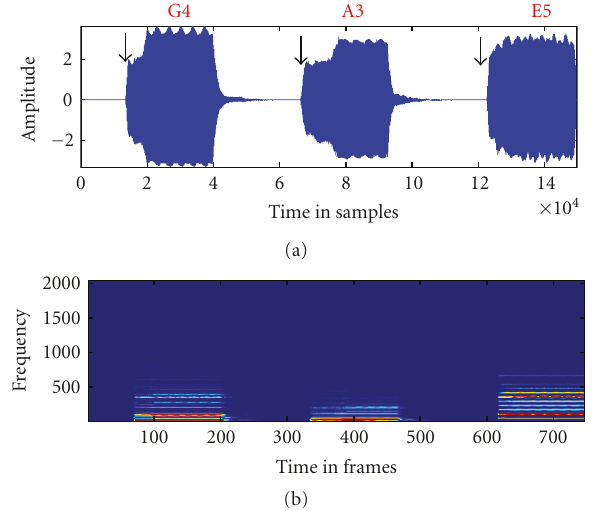
Figure 2: The waveform of the original audio signal (a) and the generated nonnegative magnitude spectrum matrix X (b). The onset locations are marked manually with arrows.